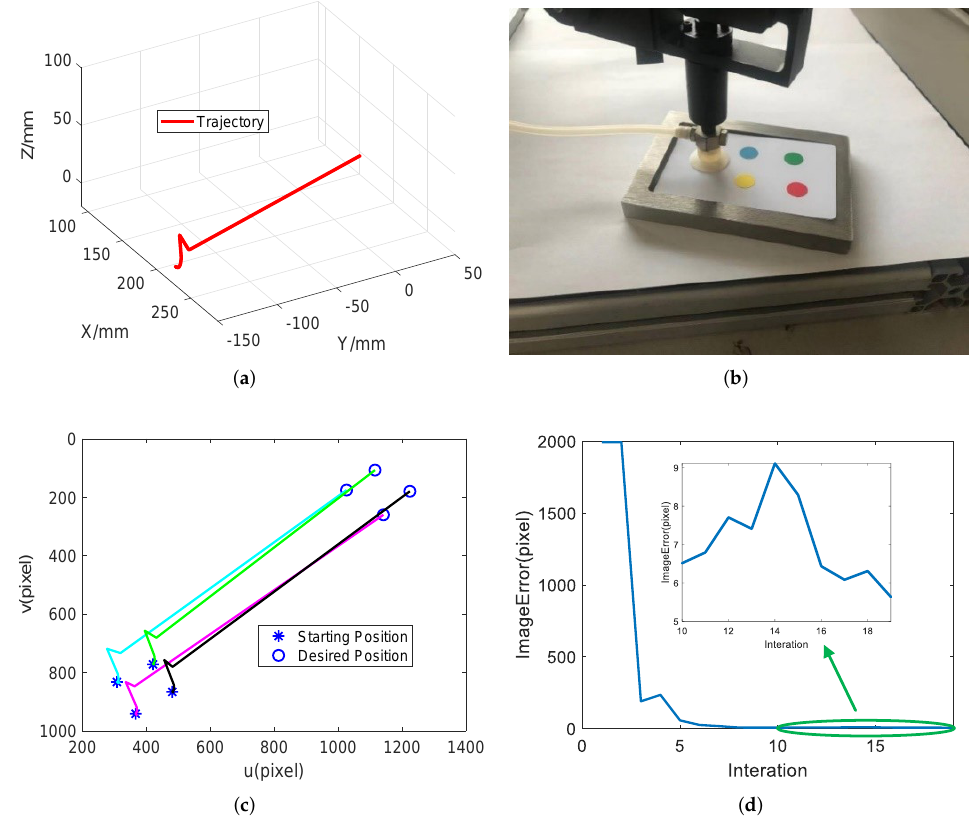
Figure 14. Experimental result of conventional method: ( a ) Starting position of the robotic arm. ( b ) The collision between the card and the slot. ( c ) Image trajectory. ( d ) Position error in the image.